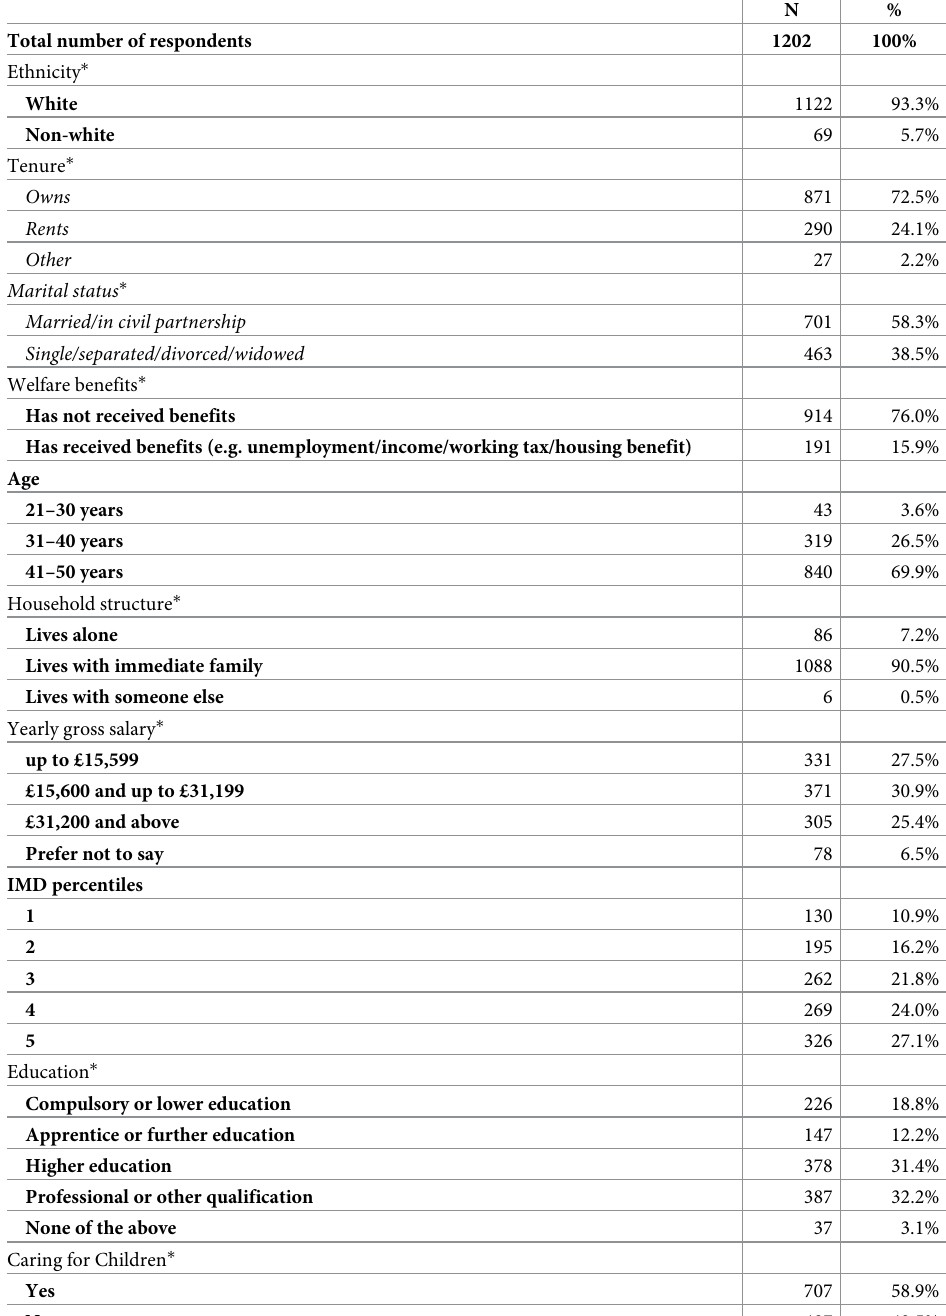
Table 1. Sociodemographic characteristics of